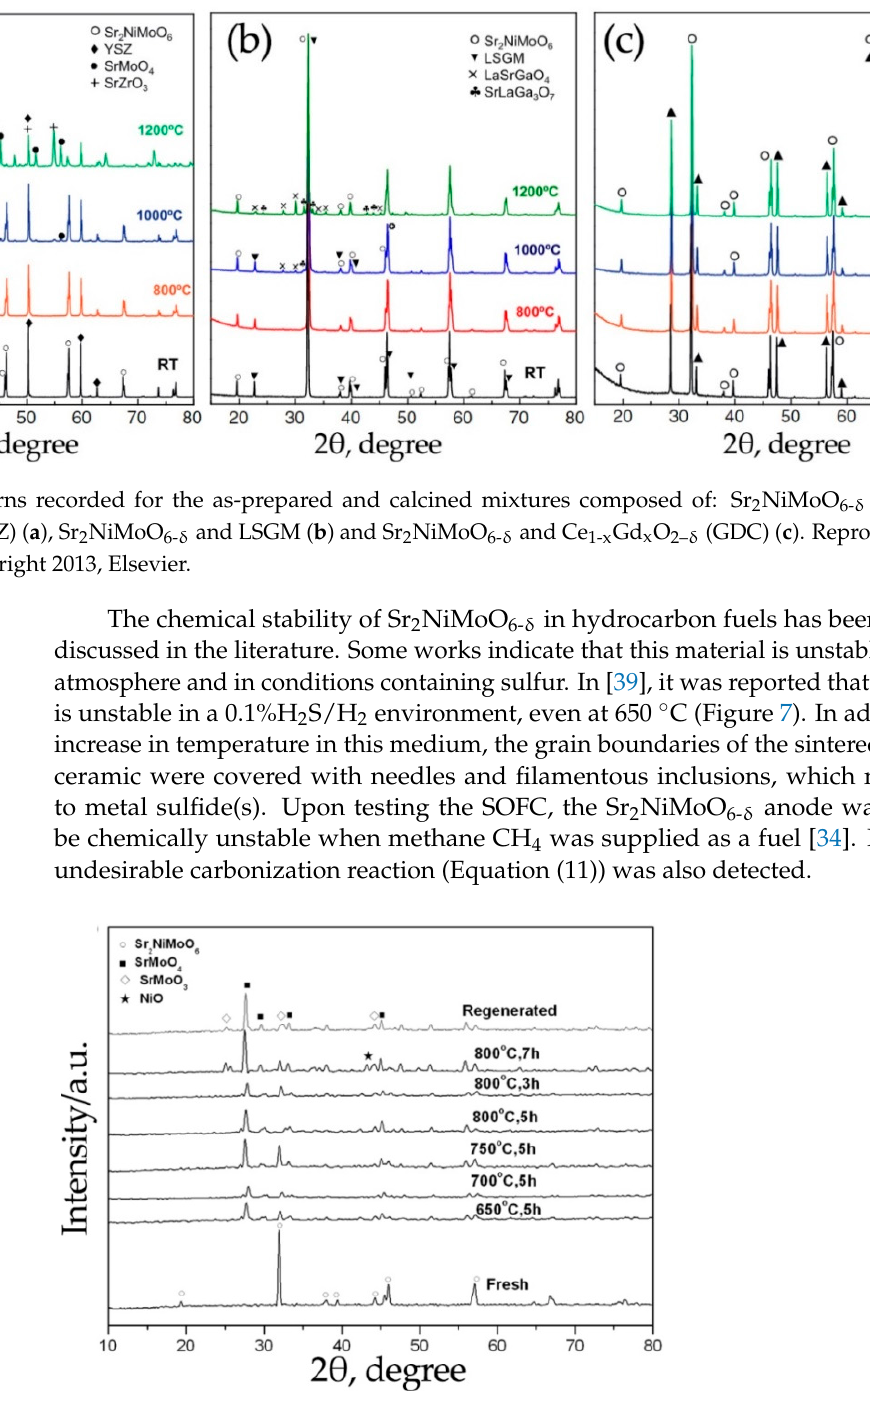
Figure 7. XRD patterns recorded for Sr 2 NiMoO 6– δ after its calcination in 0.1%H 2 S/Ar at different temperatures. Reproduced with permission [39]. Copyright 2015, Elsevier.